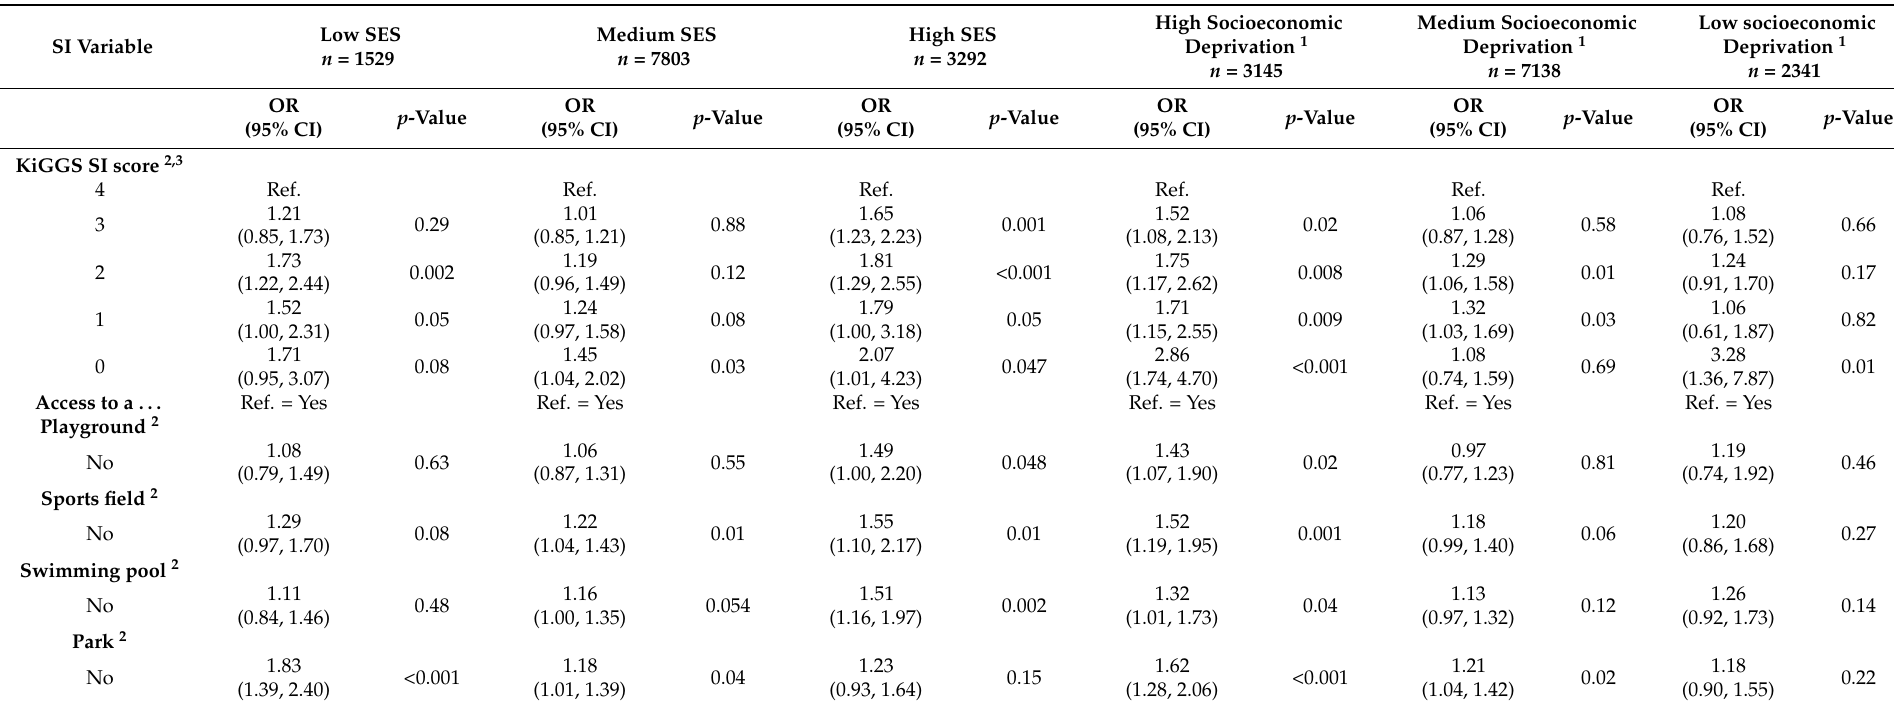
Table 3. Multivariable analyses of the association between social infrastructure and total difficulties stratified by social